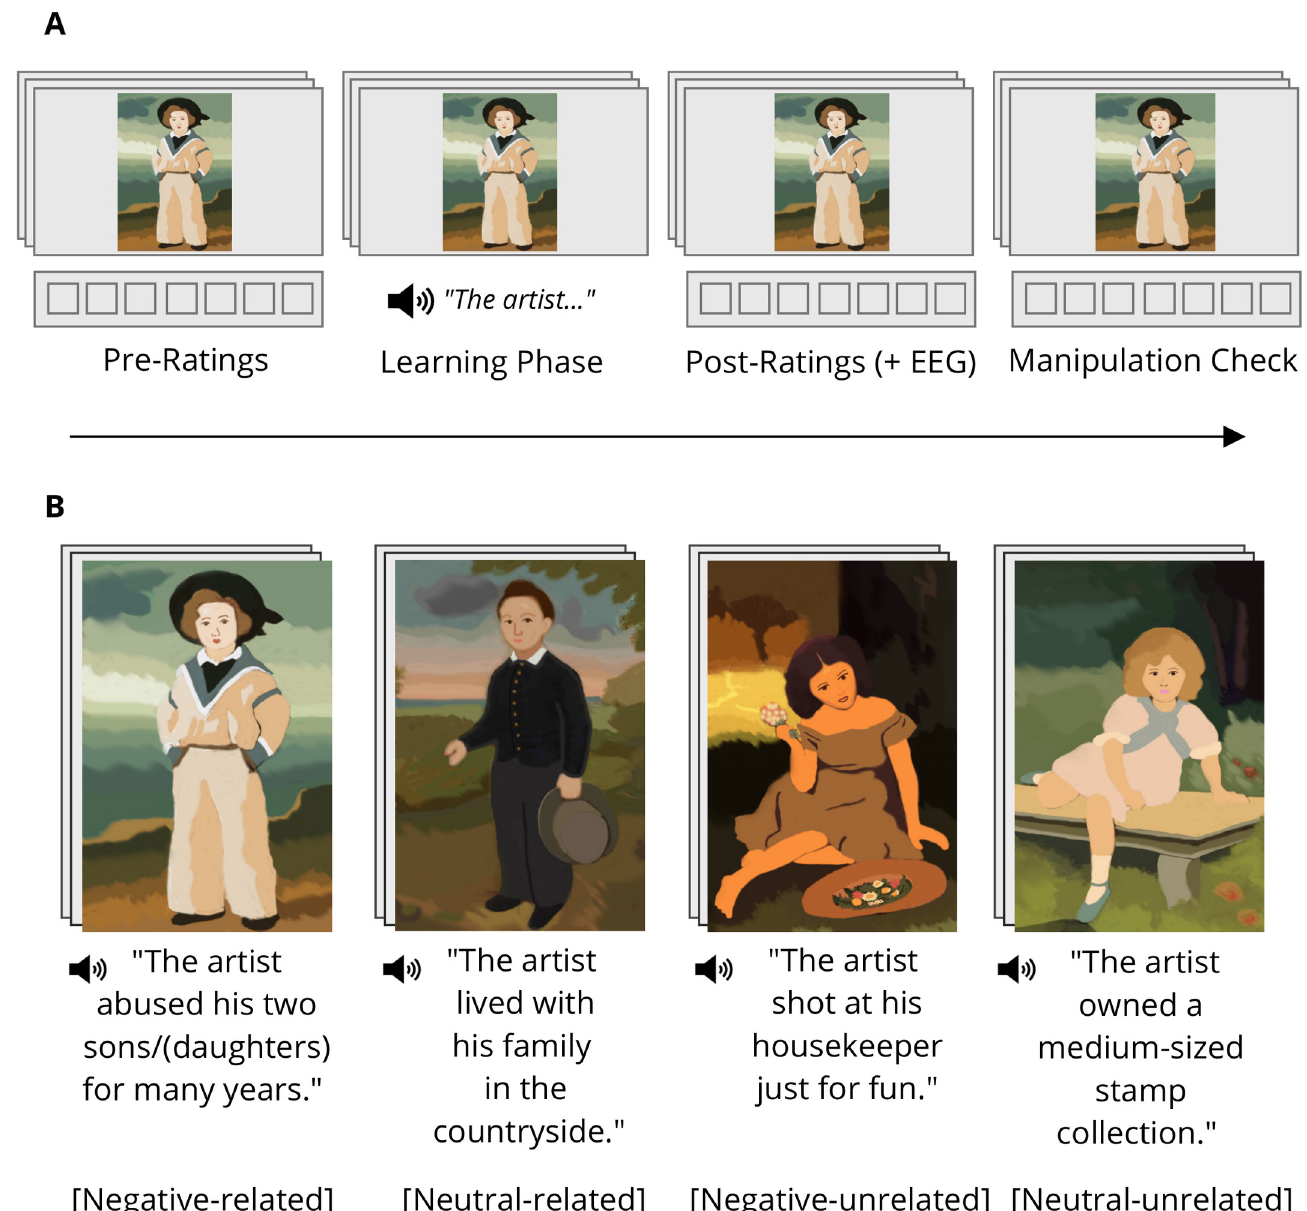
Fig 1. Experimental paradigm. (A) Procedure. All paintings were rated for liking, arousal and quality, before and after knowledge acquisition. The EEG was recorded during the second liking rating. The post-experiment questionnaire measured familiarity with the stimuli, believability of information and ability to recall the information. (B) Schematic illustration of the experimental manipulation. Participants learnt either neutral or negative information about the artist of each painting which was either related or unrelated to the content of the image. The assignment of paintings to the conditions was counterbalanced across participants. To facilitate a within-person comparison of negative and neutral conditions, paintings were matched for content, style and complexity (e.g. paintings of the boys). Matched pairs were coupled with similar, but easily distinguishable pairs (e.g. paintings of the girls). In the experiment, original artworks from different artists were used. Images have been reproduced by the authors for publication purposes. Sentences have been translated from German.